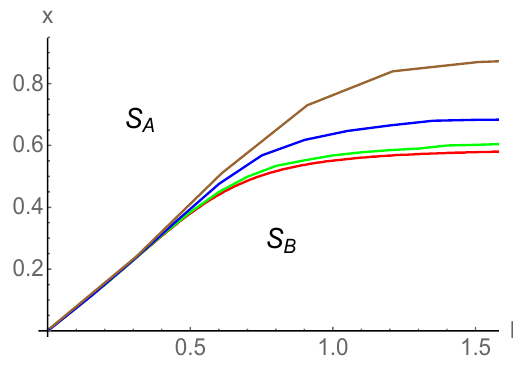
Figure 17 . Two strip phase diagram in the decon(cid:12)ned phase for various values of chemical potential. Here T = 1 : 2 T c is (cid:12)xed and red, green, blue and brown curves correspond to (cid:22) = 0, 0 : 15, 0 : 30 and 0 : 45. In units